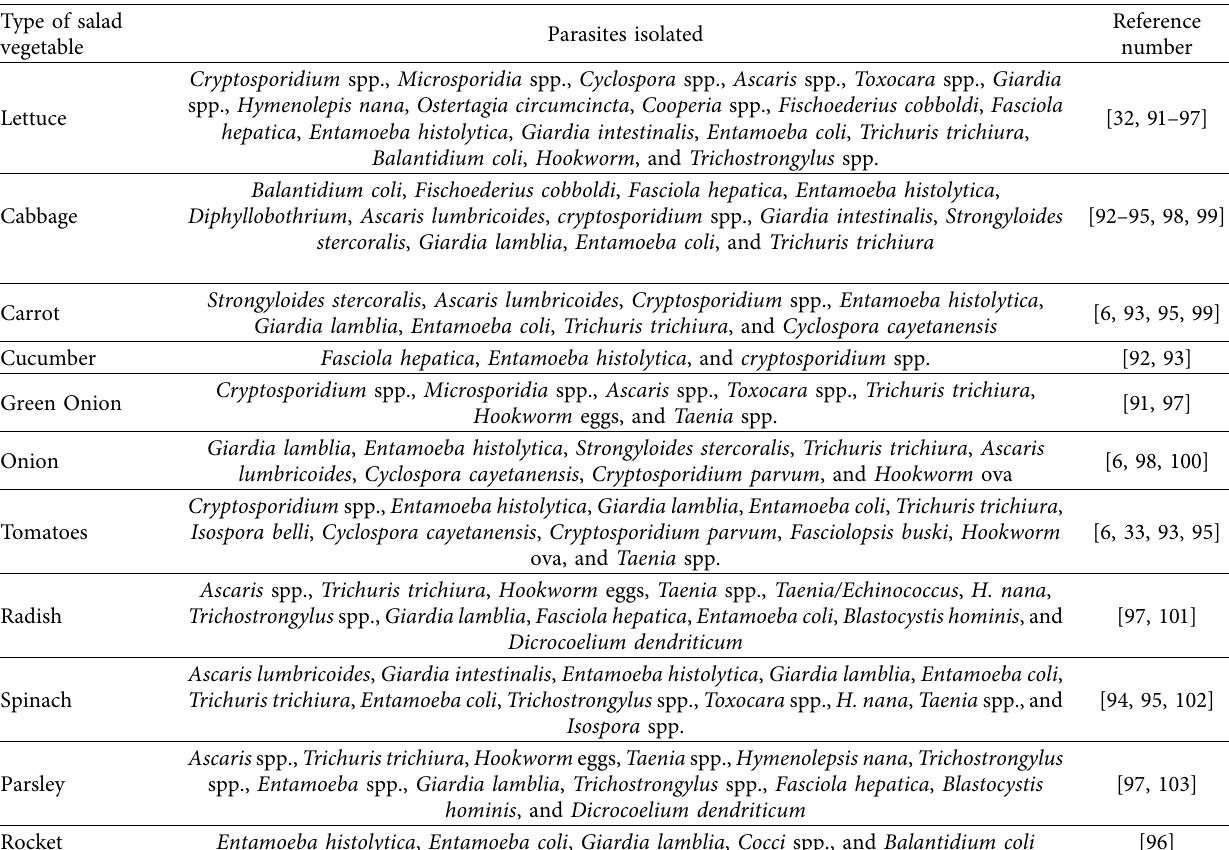
Table 2: Parasites isolated from notable